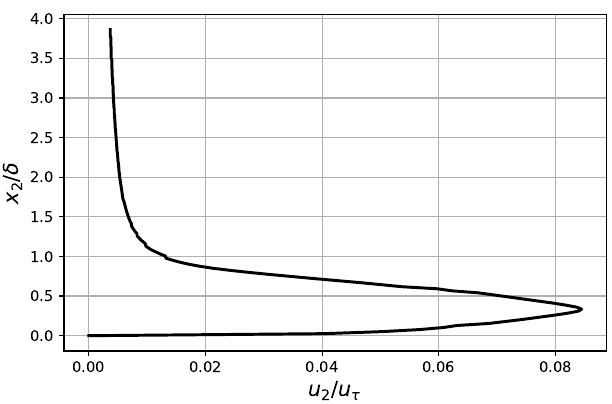
Figure 4. RMS normal-to-wall velocity profile at pressure sensor